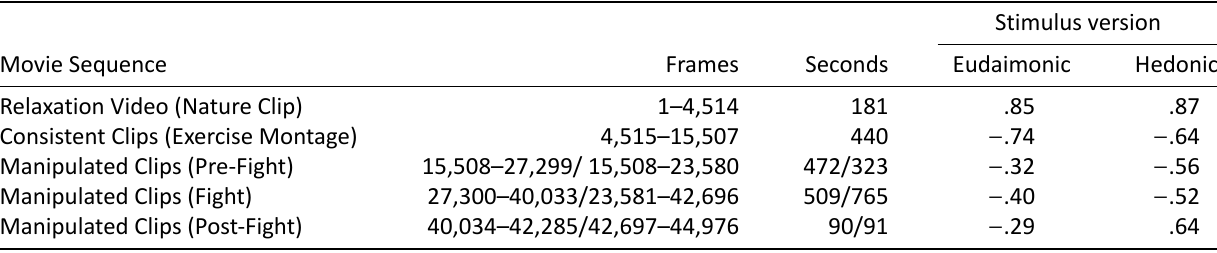
Table 2. Correlations for RTR with PVA for the identical exercise sequence and the distinct fight sequences between